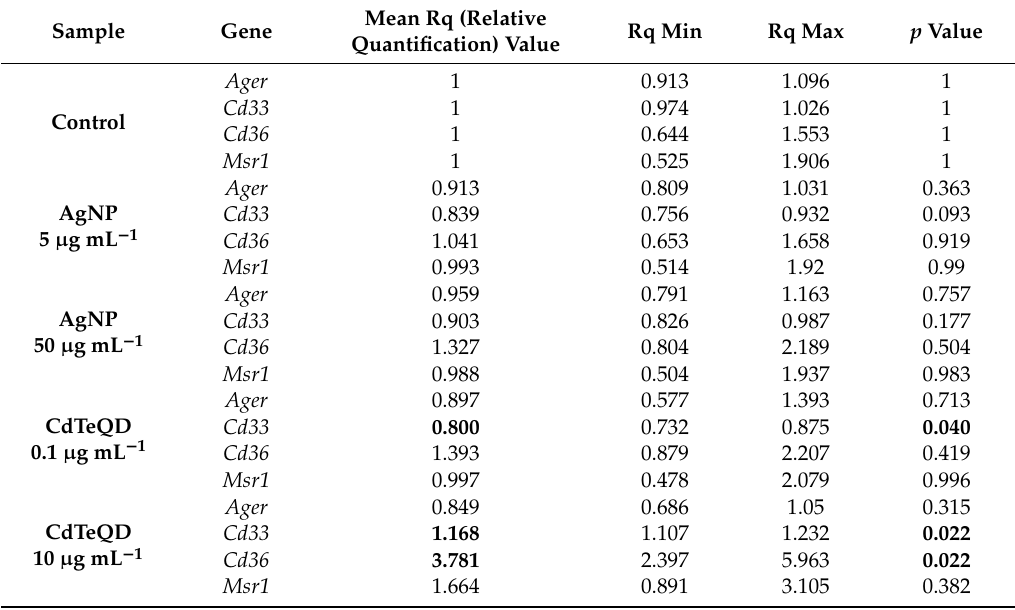
Table 1. The Msr1 , Cd36 , Ager and Cd33 gene expression of BV ‐ 2 cells after treatment with NPs for 24 h (real ‐ time PCR).